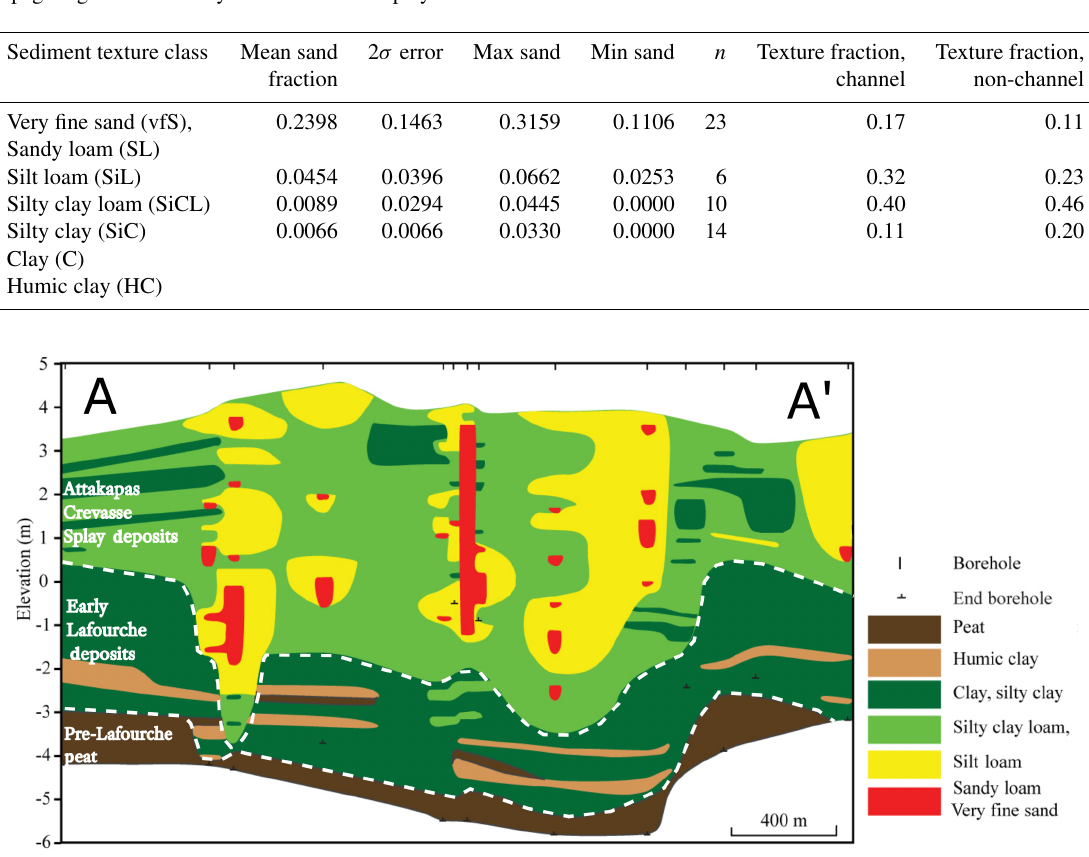
Table 1. Sediment texture data used to calculate S d . Mean sand fraction, error, and minimum and maximum values obtained from 53 sediment samples of the texture classes present in the ACS. The texture fraction in channel/non-channel deposits is calculated from the number of texture descriptions from cores collected inside or outside of our channel boundary, not from interpretations such as that shown in the cross section in Fig. 4. Weighting these data by the volumes of channel and non-channel deposits in the splay gives a total splay sand fraction of